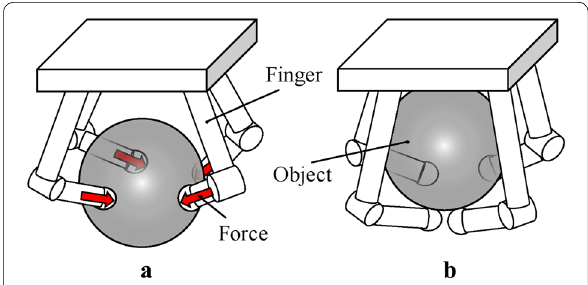
Fig. 1 Object restraint methods. a Grasping and b caging approaches